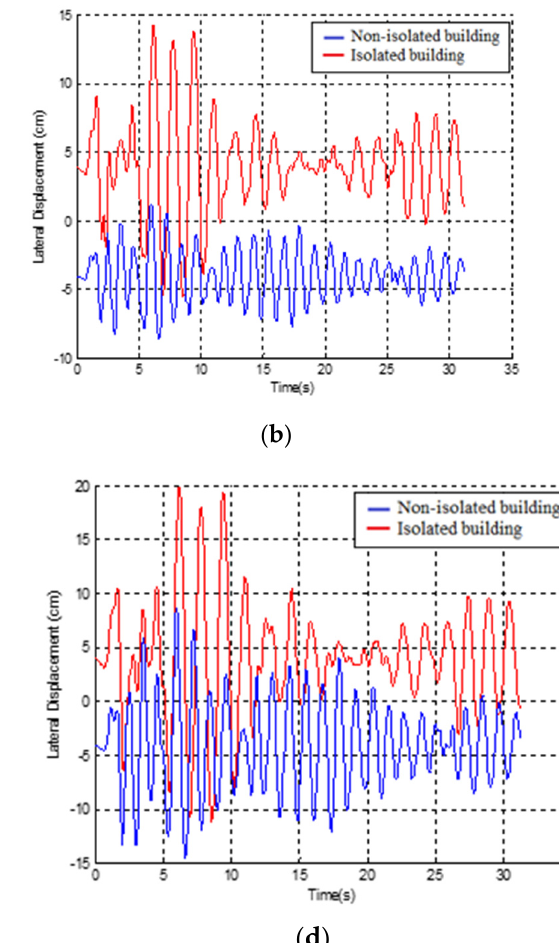
( d ) Figure 8. Hysteresis loops of rubber bumpers during impact: ( a ) base level; ( b ) first story; ( c ) second story; ( d ) third story. 0